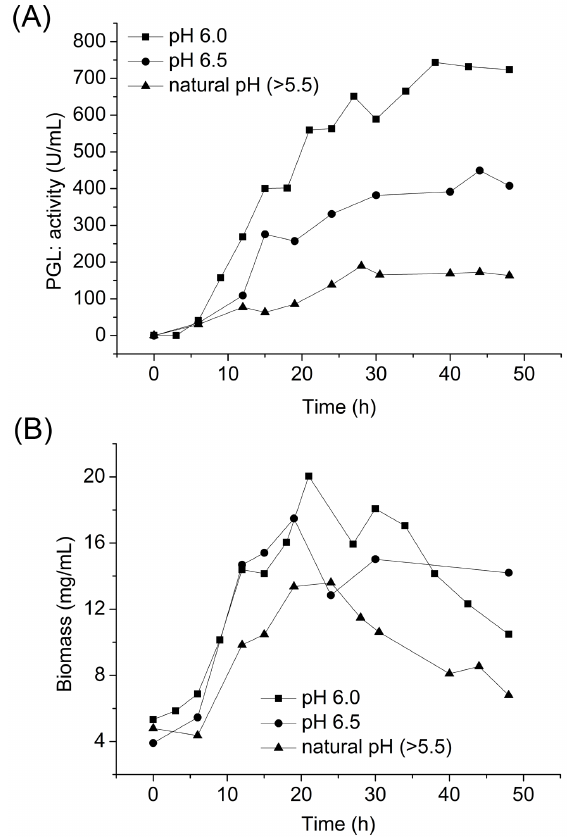
Figure 6. Effect of pH control after feeding on PGL activity (A) and biomass (B) in a 7.5 L fermentor.